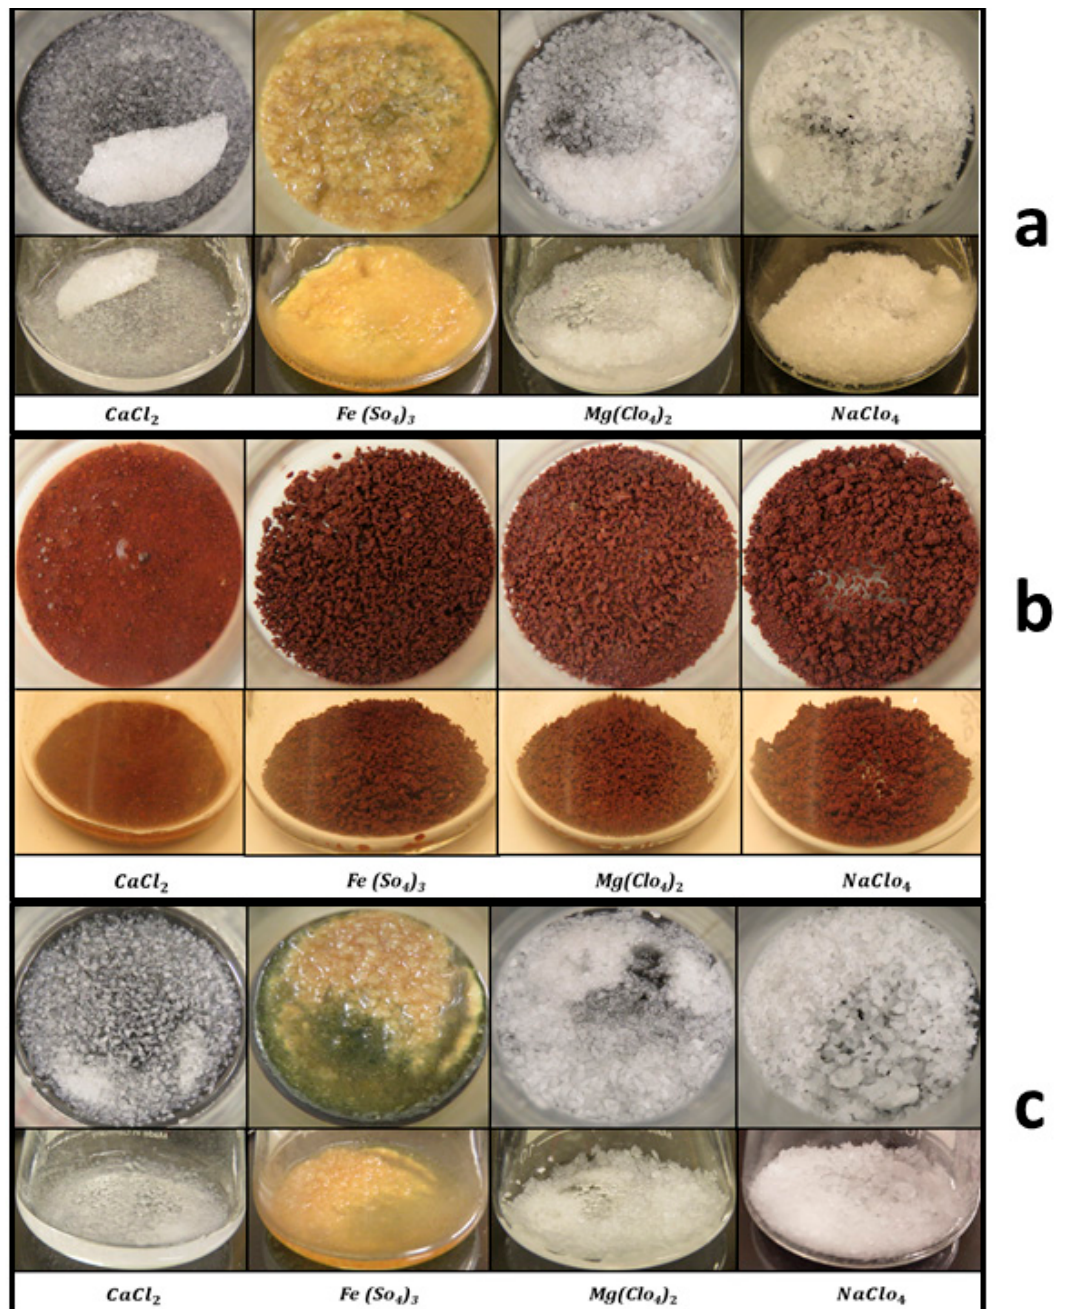
Figure 6. Images of the samples subjected to the simulated Martian atmosphere. ( a ) Experiment 1: The set of images taken after the experiment, which indicates the capture of water from the formation of brines in CaCl 2 mixture and sponge-like textures in Fe (So 4 ) 3 , Mg (ClO 4 ) 2 and NaClO 4. ( b ) Experiment 2: These are mixtures with 10% salts of the simulant weight showing brine formation in CaCl 2 and darkening of the simulant observed in the other three mixtures indicating water capture and hydrated state. ( c ) Experiment 3: Same as in ( a ) for different environmental conditions.